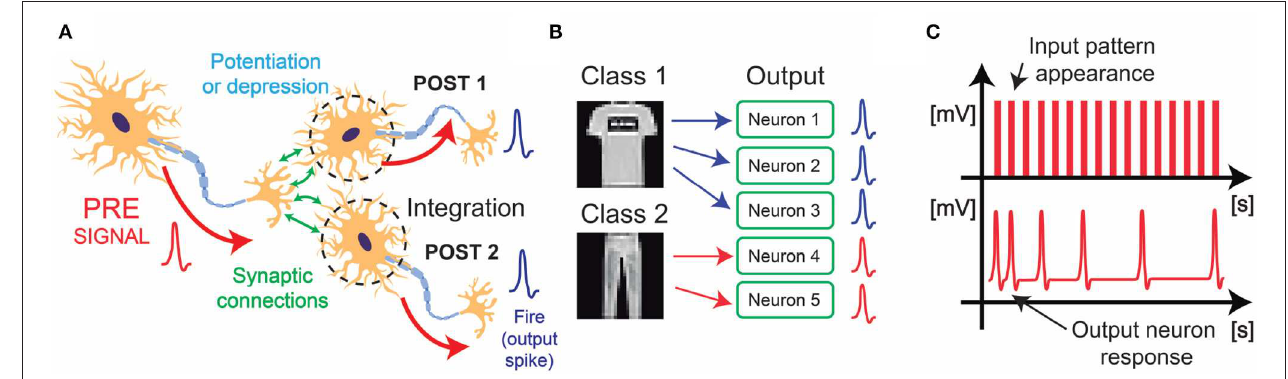
FIGURE 1 | (A) Schematic representation of biological STDP. Learning comes out by potentiation or depression of the synaptic connections, whose strength is defined by the temporal relationship between PRE-signal, and POST-signals (i.e., output spikes, “Fire,” coming from the POST neurons, POST 1 and POST 2). (B) Schematic representation of the neural redundancy, where several output neurons specialize in just one input class for mutual aid. This mechanism has been studied in biology, and it is useful for increasing classification accuracy in WTA networks. (C) Schematic representation of spike-frequency adaptation in the POSTs, for optimizing the STDP algorithm and enable efficient